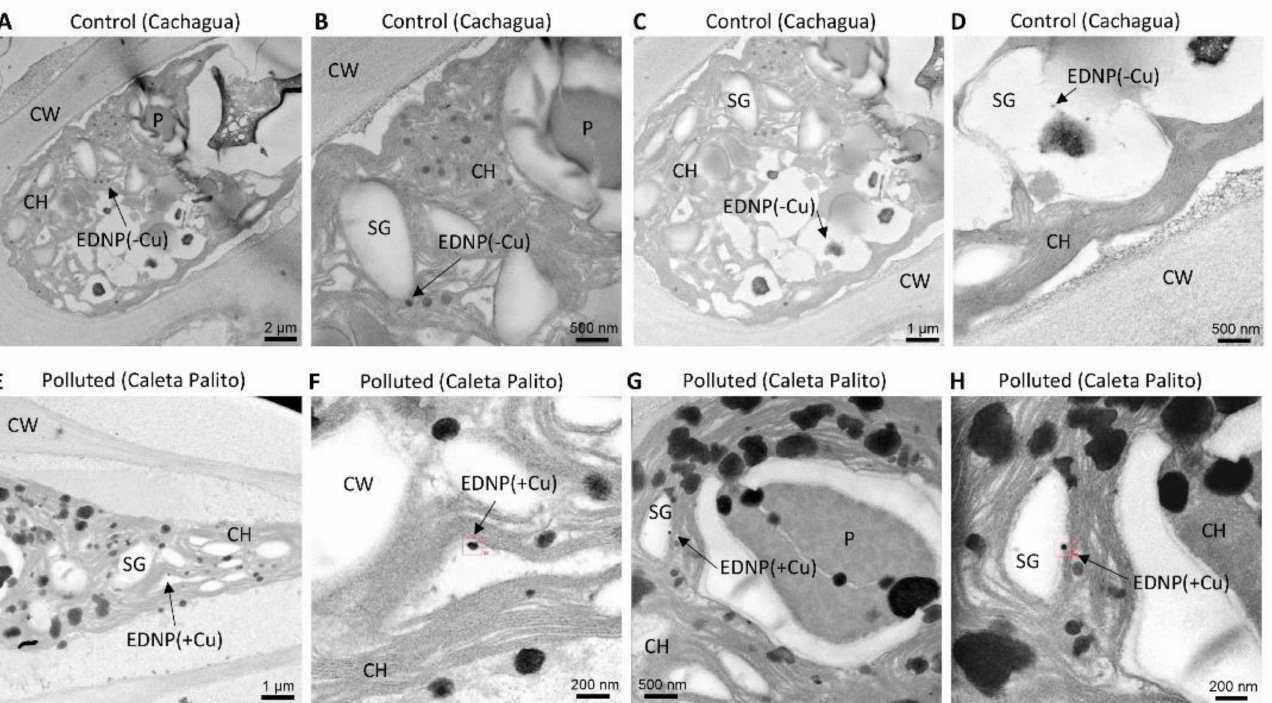
Figure 5. Pictures obtained by transmission rlectron microscopy (TEM) of a cell of U. compressa from a control site (Cachagua, A – D ) and a copper-polluted site (Caleta Palito, E – H ) at different magnifications. Arrows indicate electrodense nanoparticles (EDNP) that do not contain copper ions (-Cu) and that contain copper ions (+Cu). Cell wall (CW); starch granules (SG); pyrenoid (P) and chloroplast